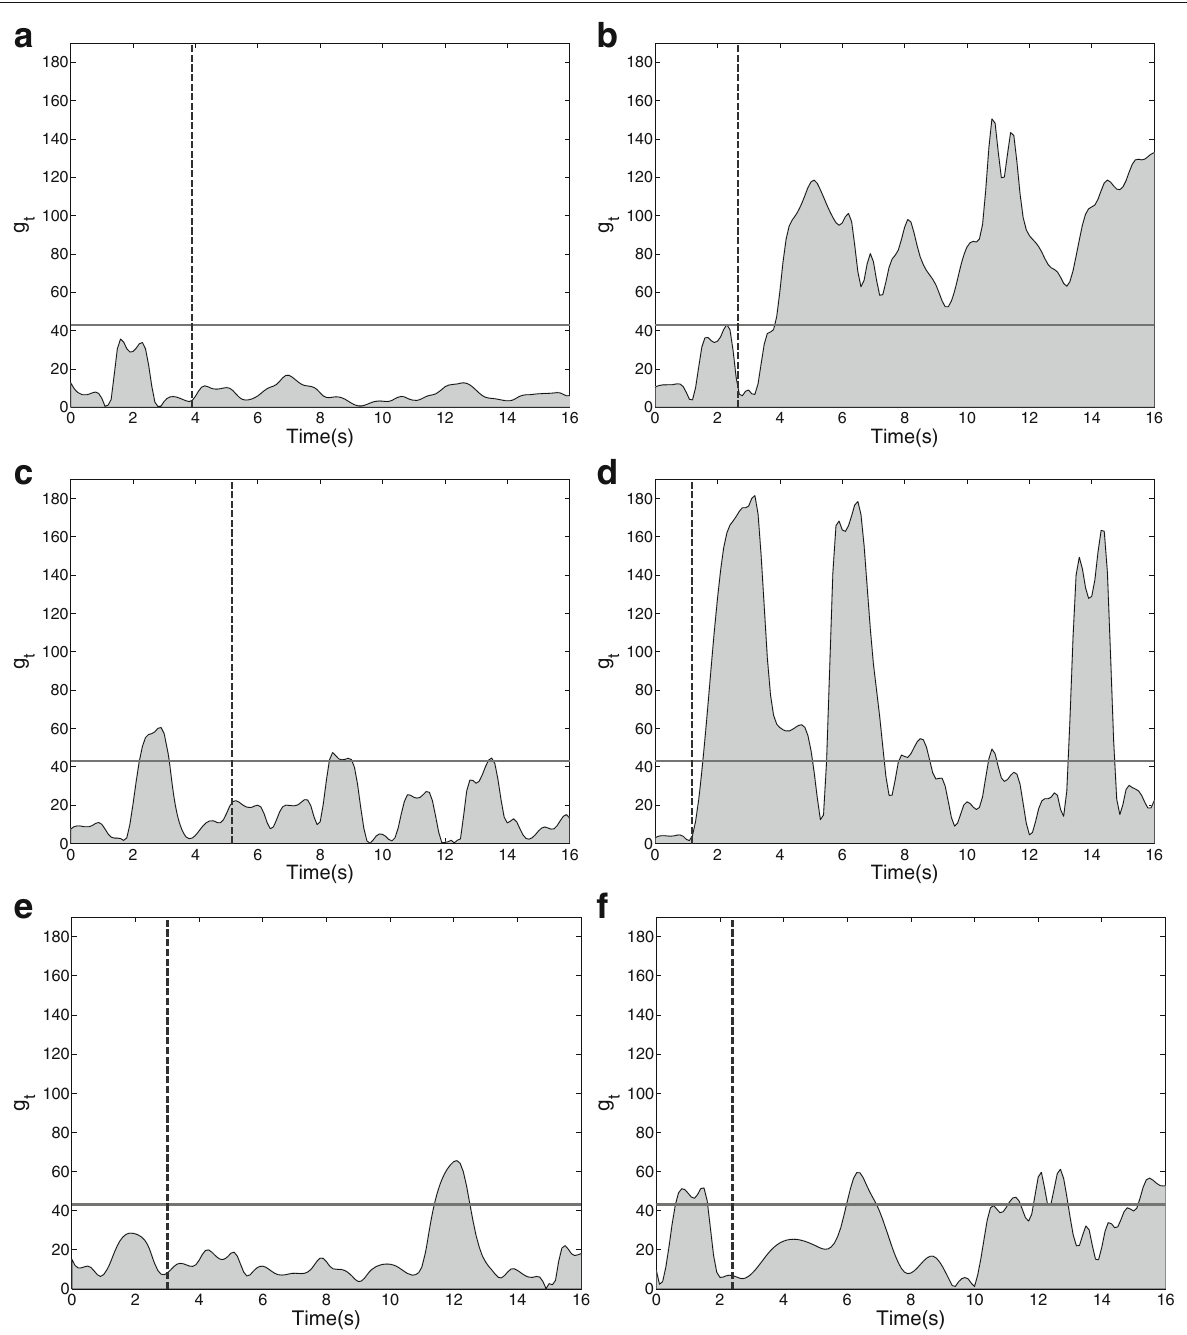
Fig. 14 Experimental testbed results. The horizontalsolidline represents the threshold. The verticaldottedline represents the moment when the attack starts. Peaks on the left side of the verticaldottedline represent false positives. a , b detection values of g t , without and with stationary watermark under replay attack. c , d detection values with stationary and non-stationary watermark under non-parametric attack. And e , f detection values with stationary and non-stationary watermark under parametric attack. a No watermark under replay attack. b Stationary watermark under replay attack. c Stationary watermark under non-parametric attack. d Non-stationary watermark under non-parametric attack. e Stationary watermark under parametric attack. f Non-stationary watermark under parametric